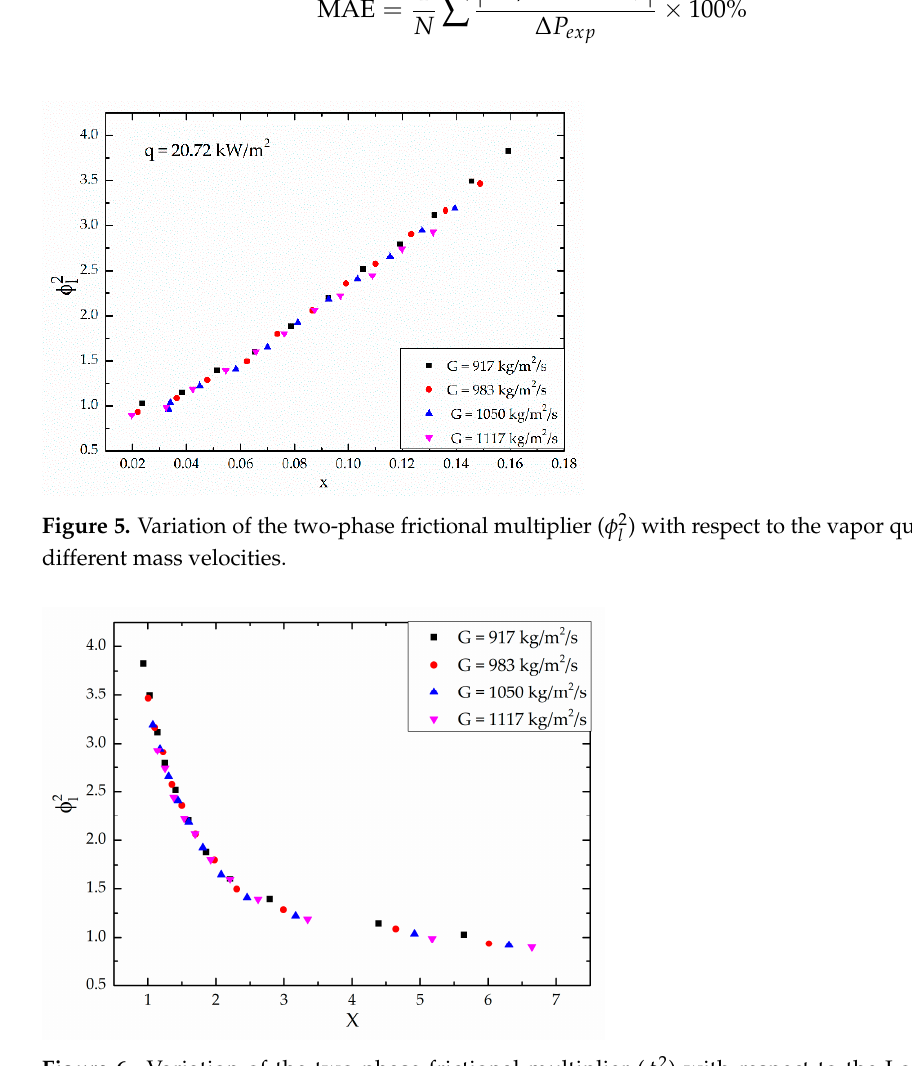
) with respect to the Lockhart and l